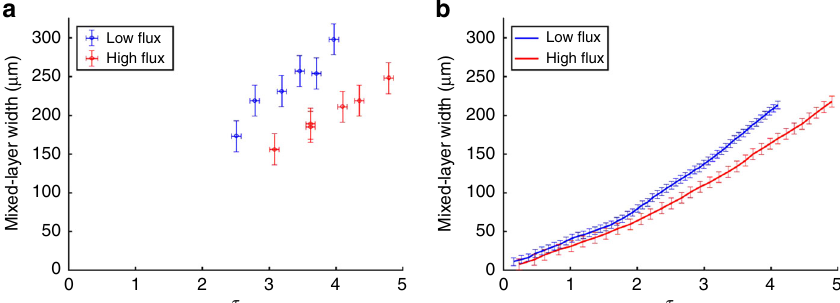
Fig. 3 Rayleigh – Taylor growth comparison. a Experimental mixed-layer width vs the RT growth factor τ , the number of instability e-foldings, τ = ∫ γ RT d t ffiffiffiffiffiffiffiffiffiffiffiffiffiffiffiffiffiffiffiffiffiffiffiffiffiffiffi p where γ RT ( t ) = A ð t Þ (cid:2) g ð t Þ (cid:2) k for high- and low- fl ux environments. The mixed-layer is smaller in the high- fl ux case, indicating a reduction in RT growth. The vertical error bars re fl ect the uncertainty of the location of the RT spike tip and bubble head, and the horizontal error re fl ects the uncertainty in the experimental time. b Simulation results of mixed-layer width vs τ . The error bars re fl ect different methods for determining the location of the RT features. These methods include the material interface location and the position determined from simulated radiographs shown in Fig. 2 Table 1 Dimensionless parameters and their physical meaning Dimensionless number